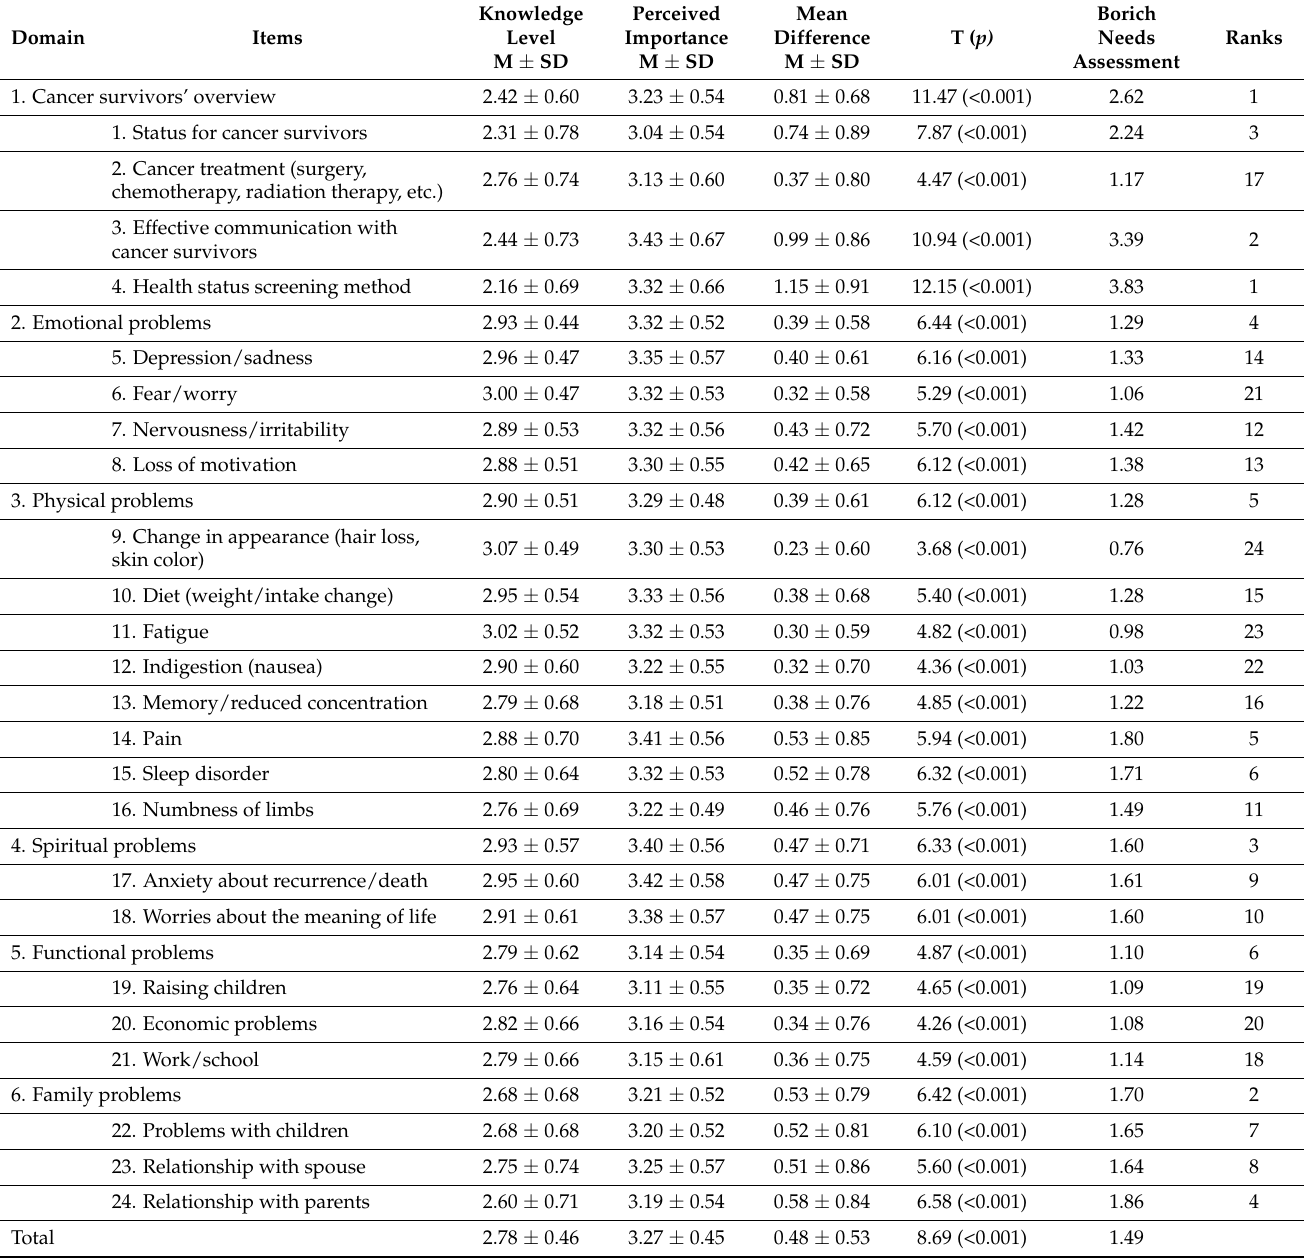
Table 3. Results of paired t -test and Borich needs assessment model to examine forest healing instructors’ educational needs regarding forest healing program for cancer